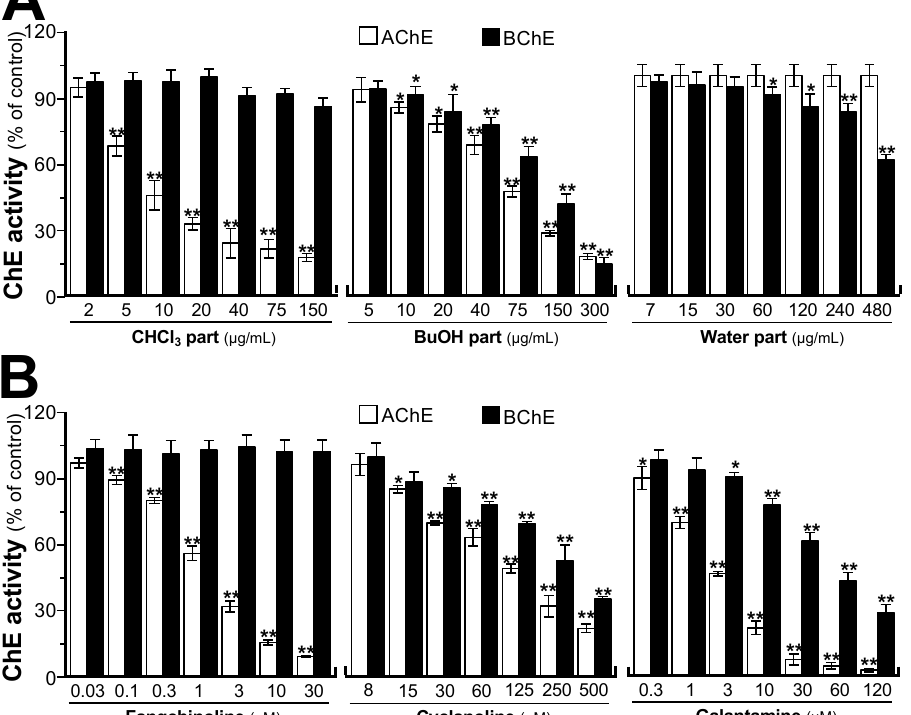
Figure 3. The extracts of STR and its main alkaloids inhibit cholinesterase activity. ( A ) STR extracts using different solvents inhibited cholinesterase activity. ( B ) STR alkaloids and galanthamine inhibited cholinesterase activity. Data are expressed as the mean ± SEM (standard error of mean) of three dependent assays, each with triplicate samples. * p < 0.05 and ** p < 0.01 compared to control.